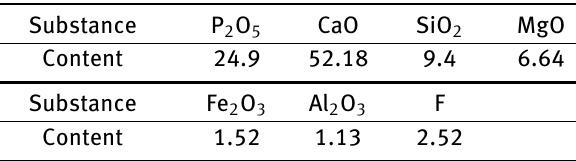
Table 1: Mass fraction of each chemical component of phosphate rock % (wt.)